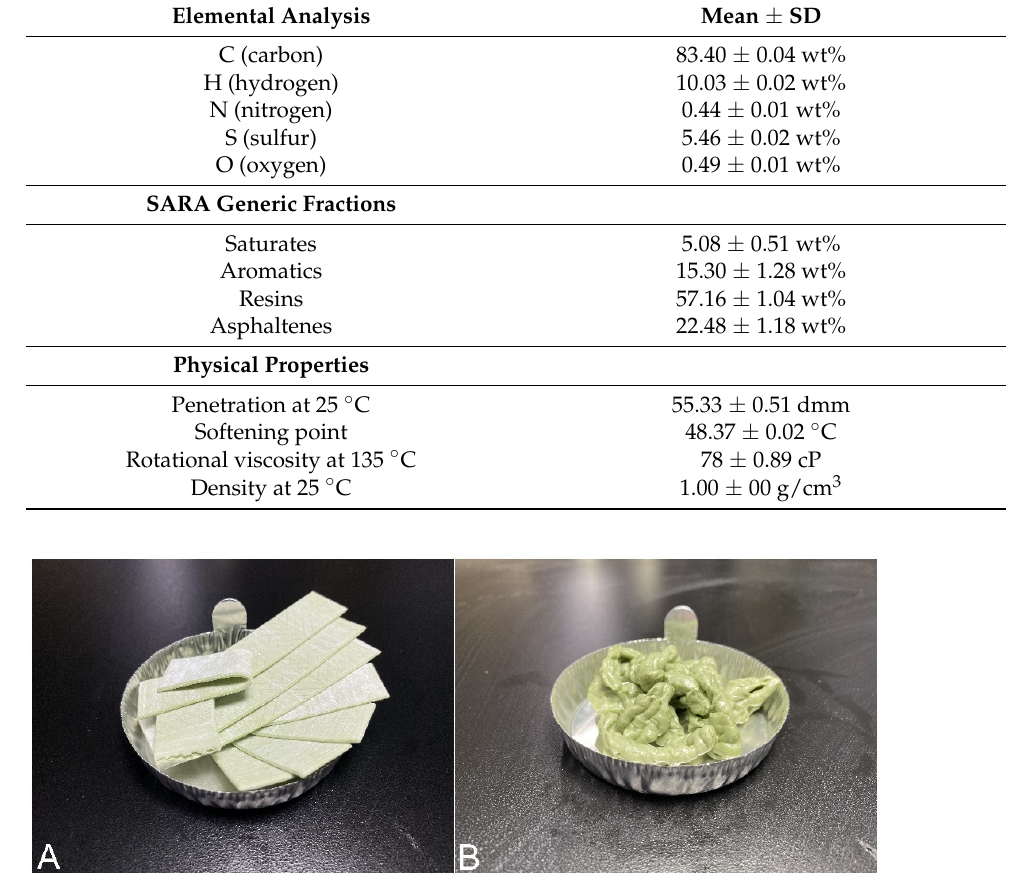
Table 1. Physicochemical properties of base AP-5 asphalt.